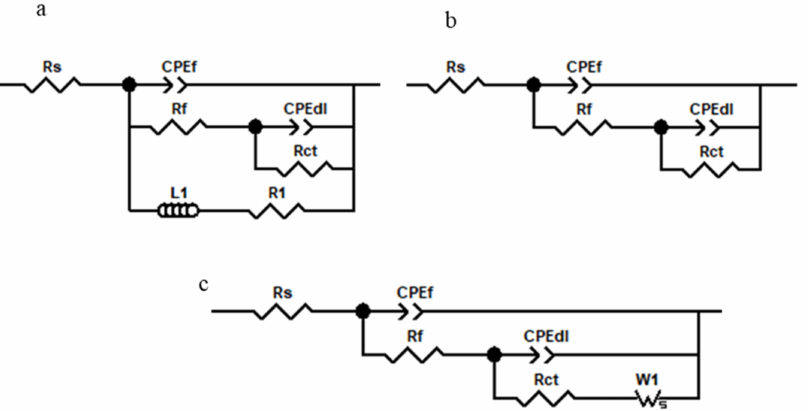
Figure 5. Different equivalent circuits used to fit EIS diagrams of cerium coated AA5083 samples in 3.5 wt.% NaCl corrosive solution provided by different pretreatment conditions. ( a ) Used for AA5083 and without pretreatment aluminum plate (A Method), ( b ) used for the coated lates pretreated